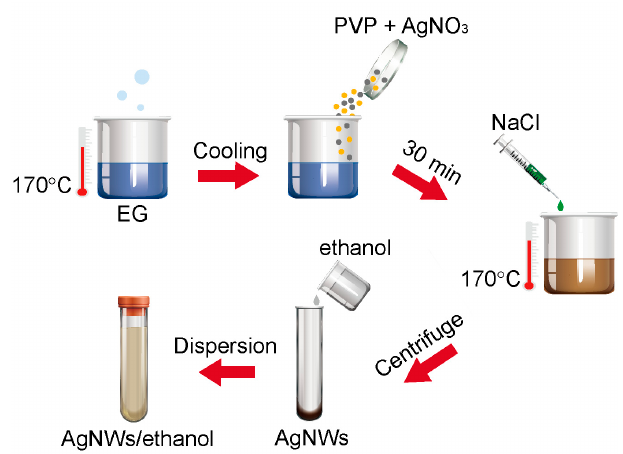
Figure 1. Schematic of the synthesis procedure of AgNWs. AgNW: silver nanowire.